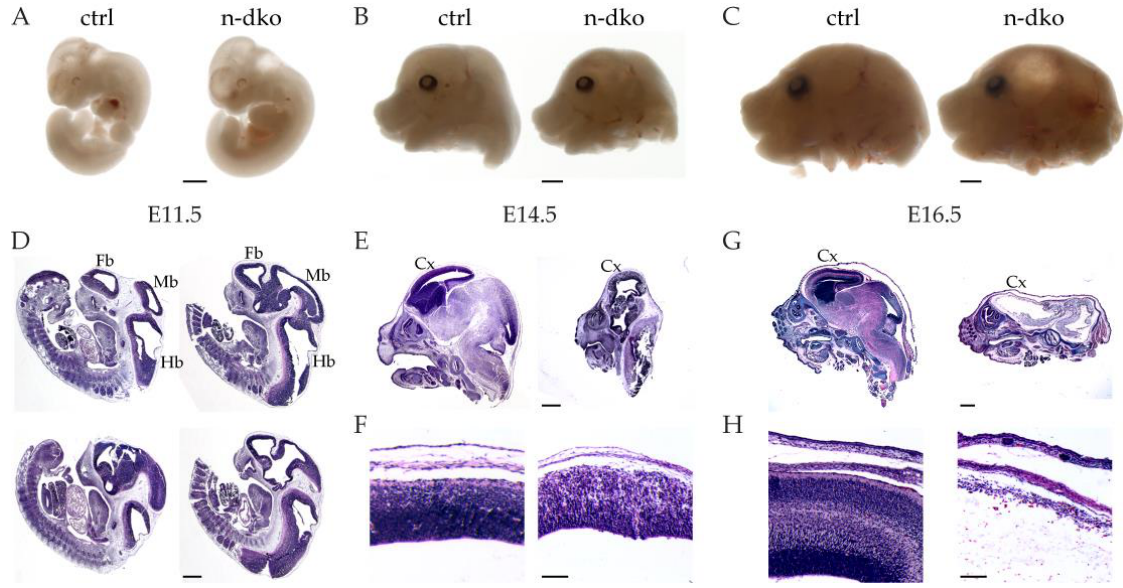
Figure 2. Histological analysis of neural profilin 1 and 2 knockout (n-dko) embryos. ( A ) E11.5 n-dko dissected embryos show no evident anatomical differences from control littermates. ( B ) E14.5 n-dko embryos have a smaller head than controls. ( C ) In E16.5 n-dko embryos, a translucent bubble in place of the cerebral cortex region is visible. ( D ) Hemalum/eosin (H&E)-stained sagittal sections of E11.5 n-dko embryos show no major defects in the patterning of the brain except an expansion of the hindbrain vesicle, possibly due to a delay in neural tube closure in the cervical region. ( E ) H&E-stained sagittal sections of E14.5 n-dko embryos show severe developmental defects in the forebrain, midbrain, and hindbrain. ( F ) The developing cortex of E14.5 n-dko embryos is severely compromised and does not show any layering, while cell density is strongly reduced. ( G ) In H&E-stained sagittal sections of E16.5 n-dko embryo heads, no brain structure can be identified, and the region is virtually empty. ( H ) Magnification of the cortical area shows the complete absence of the cortex in E16.5 n-dko embryos. Fb: forebrain, Mb: midbrain, Hb: hindbrain, Cx: cortex. Scale bars: 2 mm in ( A – C ); 1 mm in ( D , E , G ); 200 μ m in ( F , H ).